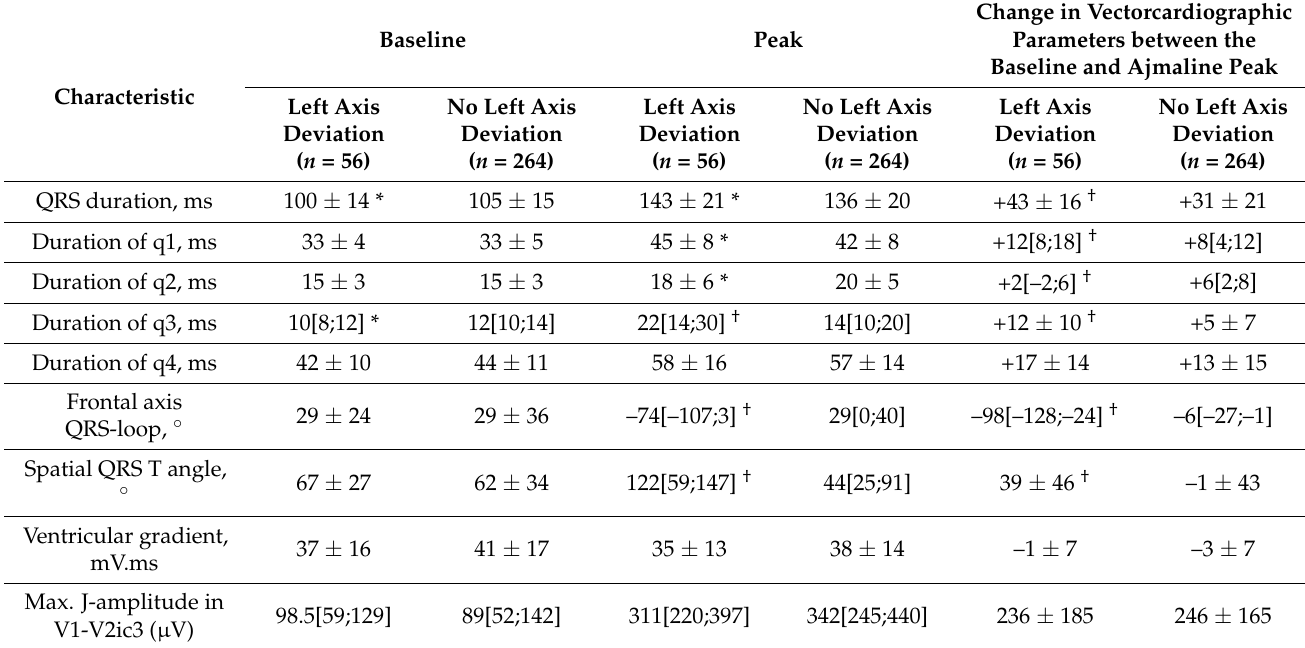
Table 2. Vectorcardiographic parameters in patients with a left axis deviation of >30 ◦ at baseline, at ajmaline peak, and the change between the baseline and ajmaline